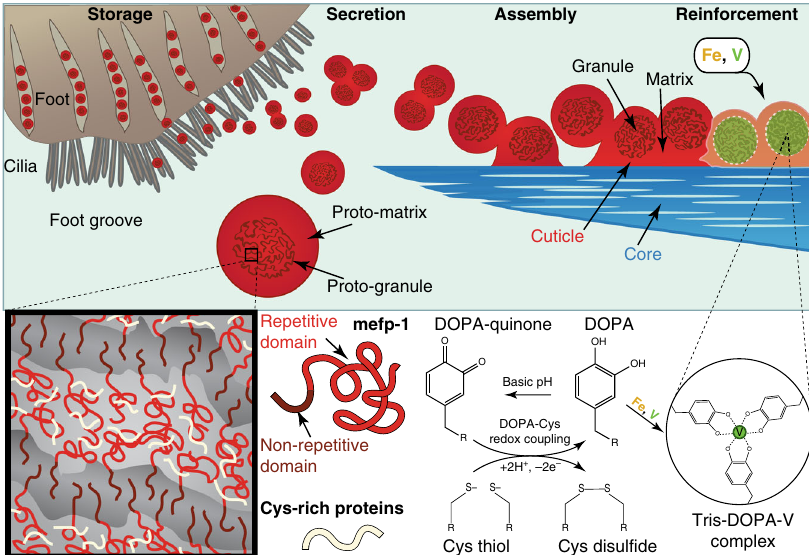
Fig. 5 Schematic model of cuticle assembly via co-existing condensed liquid phase vesicles. To achieve the high degree of compositional, structural and mechanical hierarchy observed in the native byssus cuticle, mussels store the protein precursors as a LLPS of two co-existing phases. The main protein component mfp-1 and the Cys-rich proteins (mfp-16 – 19) are immiscible due to the amphiphilic nature of mfp-1, leading to phase separation into a bicontinuous structure that characterizes the proto-granule. During secretion and cuticle assembly, the proto-matrix of nearby secretory vesicles fuses forming the continuous matrix of the cuticle, possibly cross-linked via cysteine residues. The intricate nanostructure of the proto-granule is maintained in the newly formed cuticle and contains a much higher local concentration of DOPA than the surrounding matrix. Thus, when metals are added to the thread in a secondary curing, the metal ions that have the highest stability complex with DOPA (i.e., vanadium) diffuse into the granule where they become concentrated relative to iron. This results in different viscoelastic behavior of the granule and matrix, which is likely an adaptive function to life on the highly dynamic rocky seashore. Cysteine may play a secondary, but equally important role as a reducing agent that counteracts the spontaneous oxidation of DOPA to DOPA-quinone under basic conditions, which enables strong metal coordination cross-link